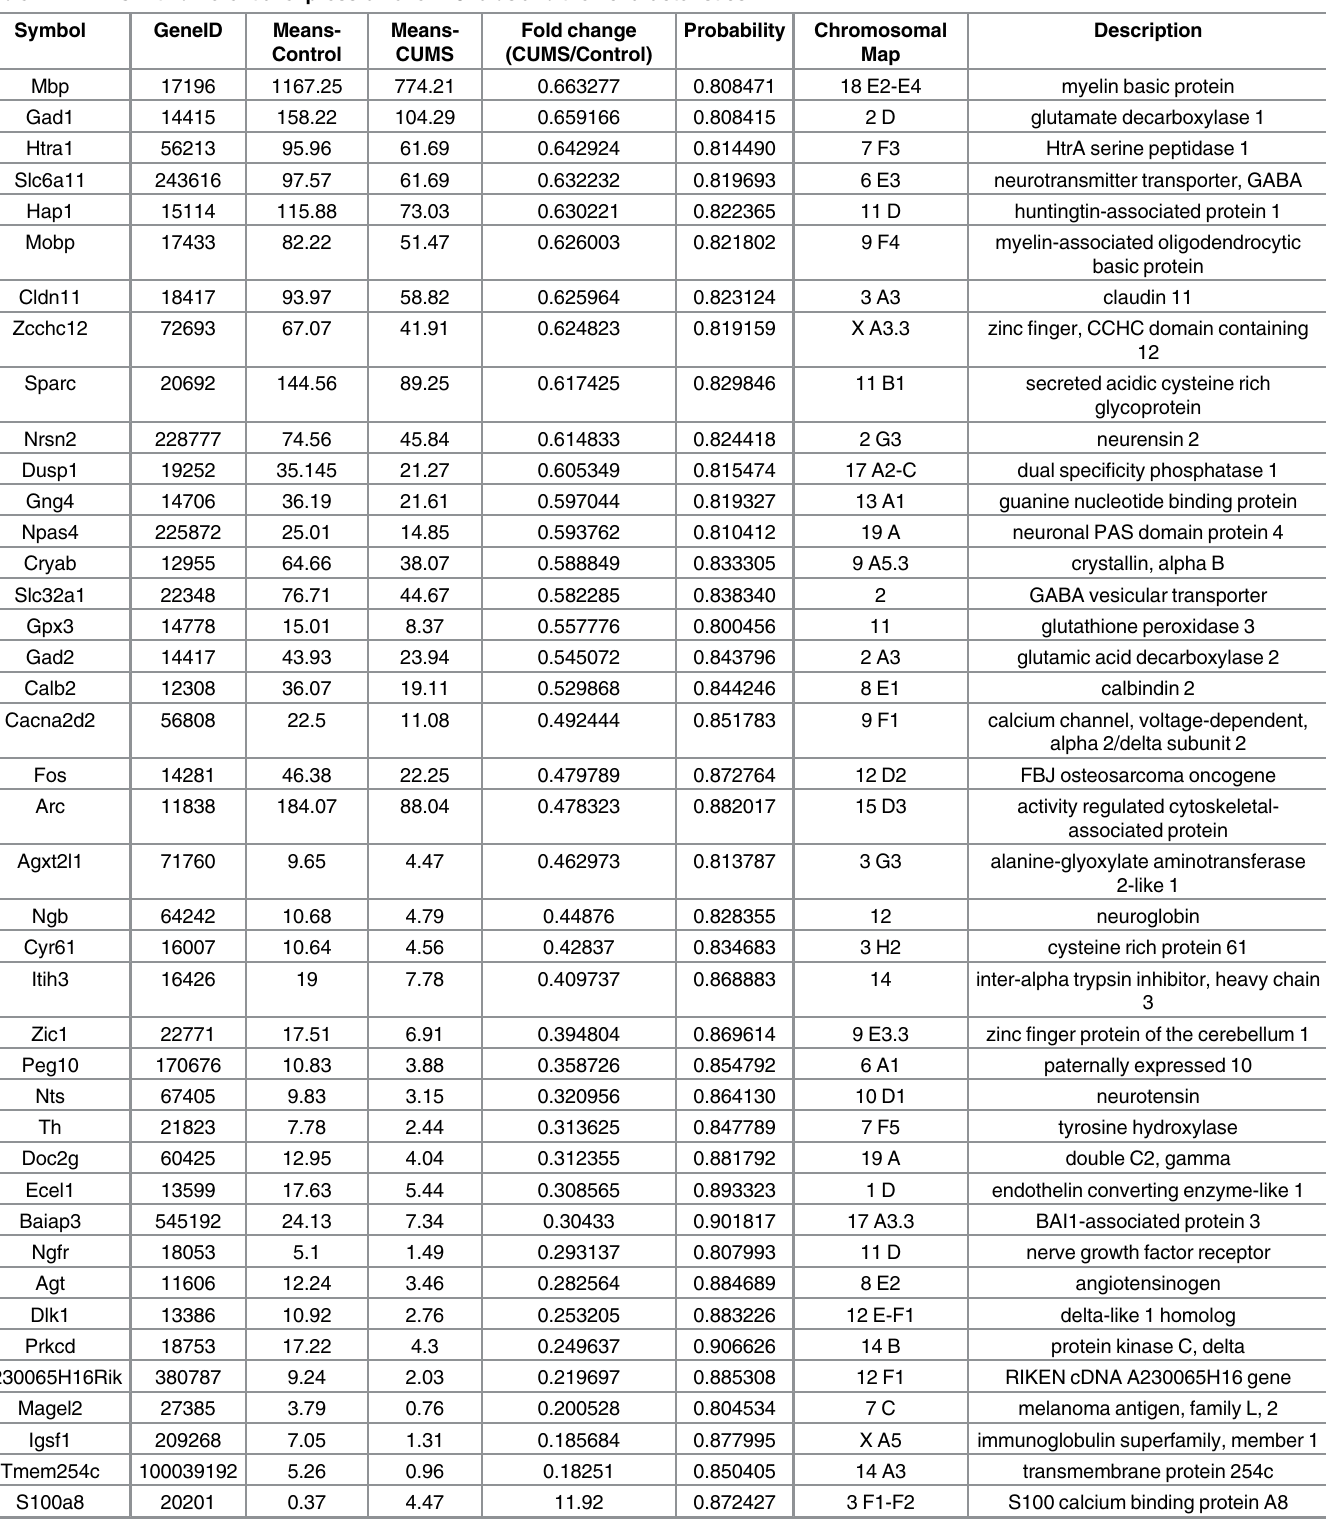
Table 1. mRNAs with differential expression over 1.5 folds and their